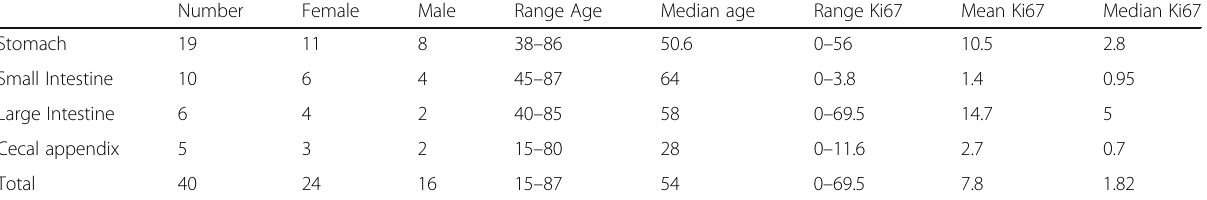
Table 1 Distribution of the 40 cases by sex, age (median) and Ki67 (mean and median) in relation to the different organs